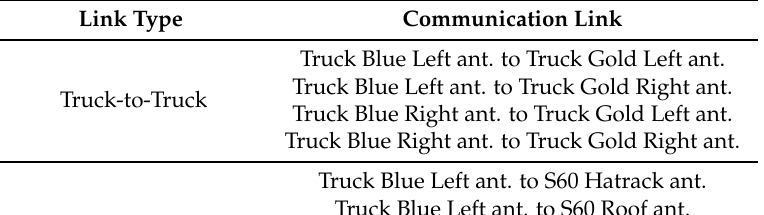
Table 2. Definition of NLOS link